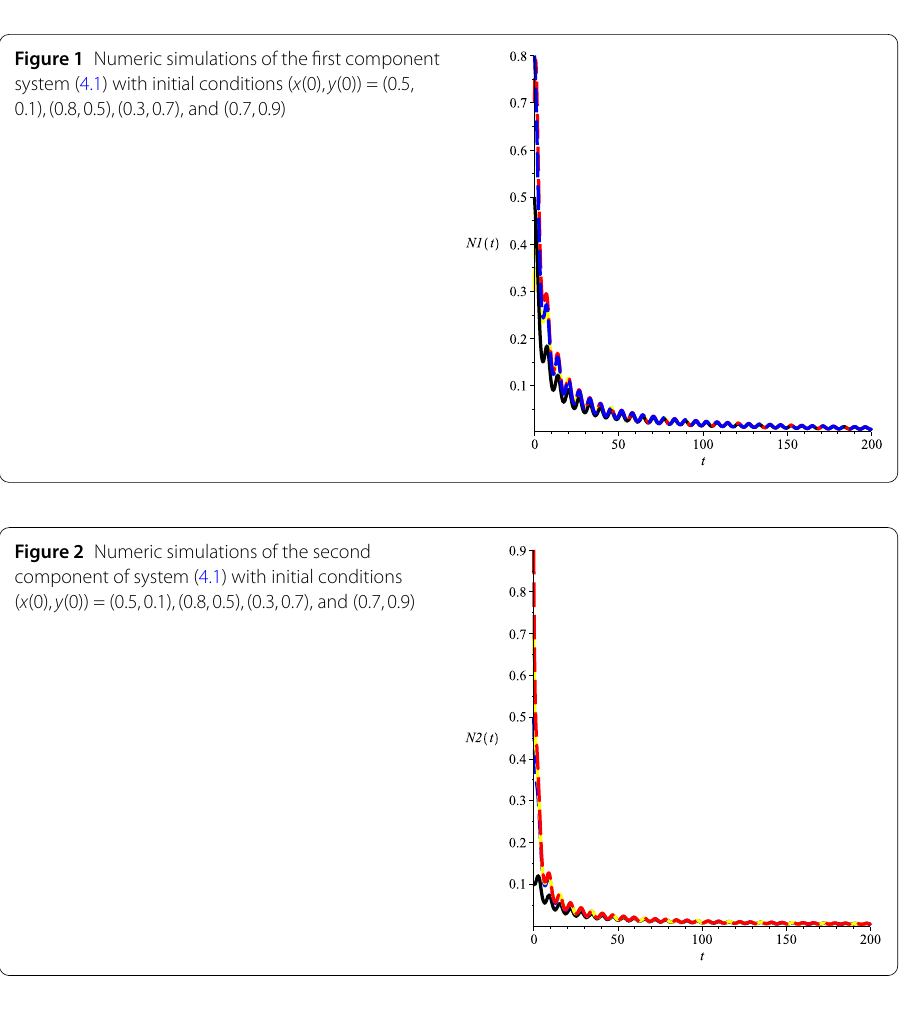
Figure 1 Numeric simulations of the first component system (4.1) with initial conditions ( x (0), y (0)) = (0.5,